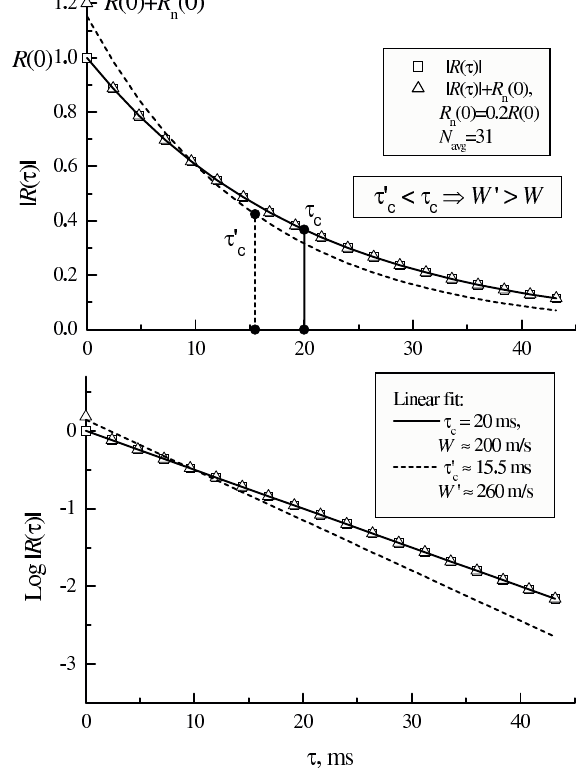
Fig. 9. The effect of zero-lag noise on estimating spectral